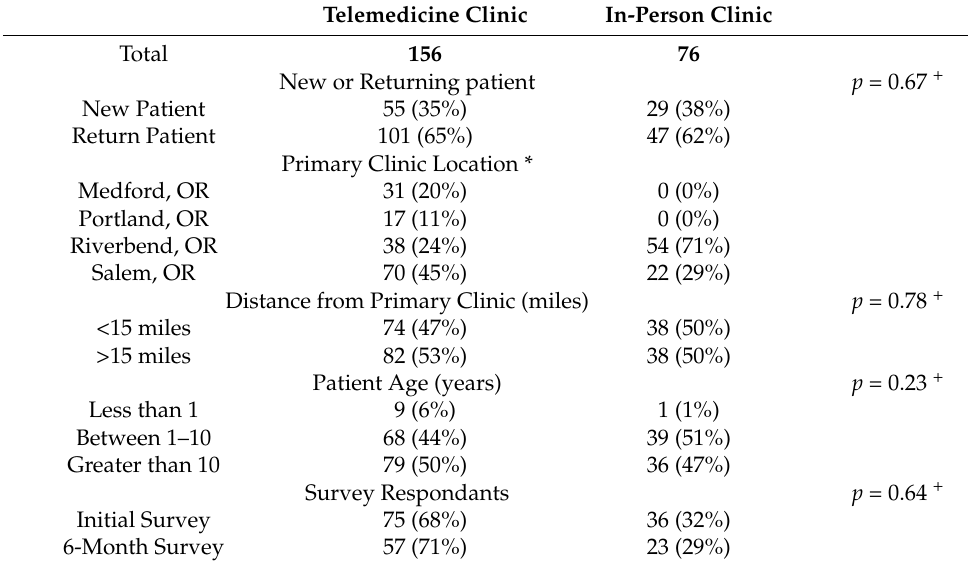
Table 1. Characteristics of patients seen in pediatric gastroenterology outreach clinics. Telemedicine